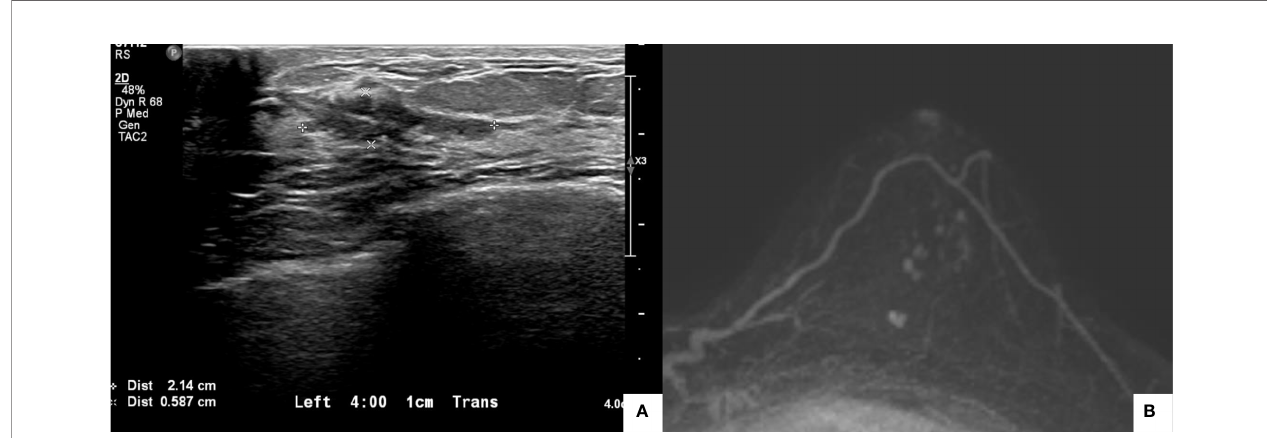
FIGURE 2 | Posttreatment imaging evaluation. Ultrasonography showed that the dimensions of the malignant mass had decreased to 2.1 × 1.0 cm (A) . Magnetic resonance imaging showed that the biopsy-con fi rmed malignant mass and multiple suspicious daughter nodules (total extent measuring 2.1 cm) in the left breast had decreased in size (B)